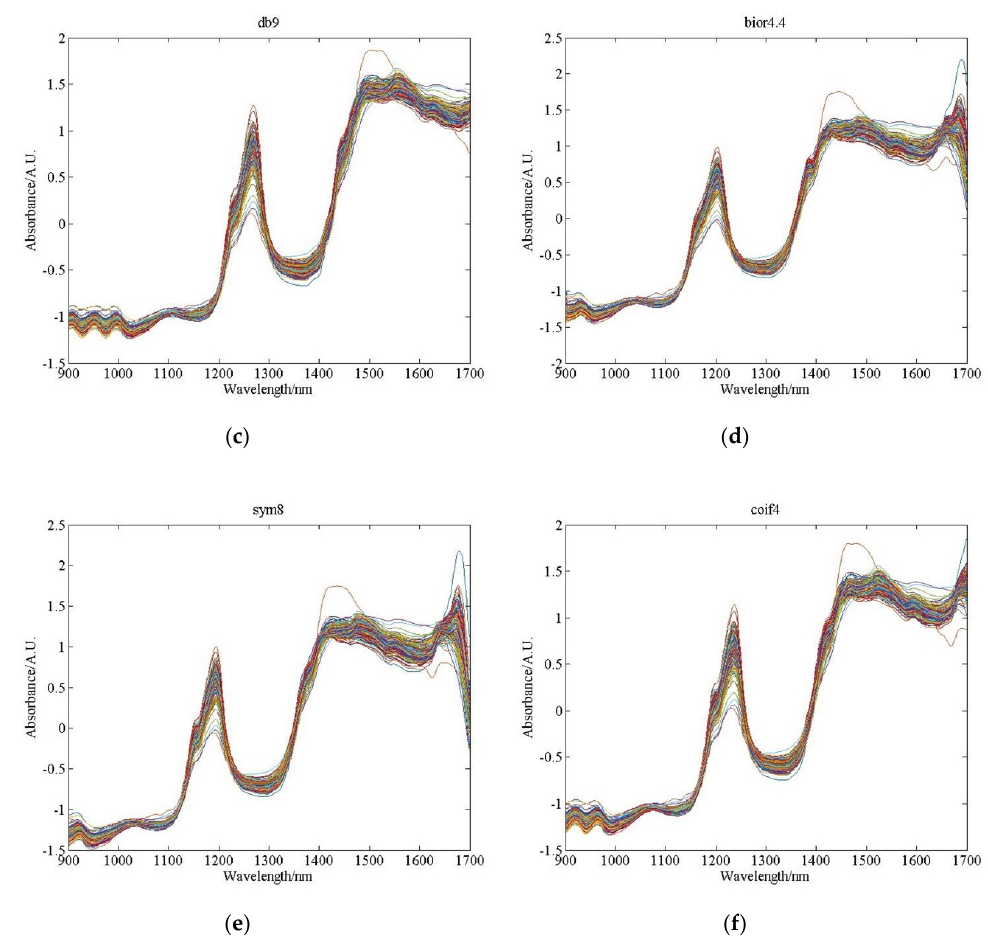
Figure 4. NIR raw spectra, SNV pretreated spectra, and wavelet compression spectra of pine nut powder, ( a ) The raw spectra, ( b ) The SNV pretreated spectra, ( c ) The spectra after being compressed by